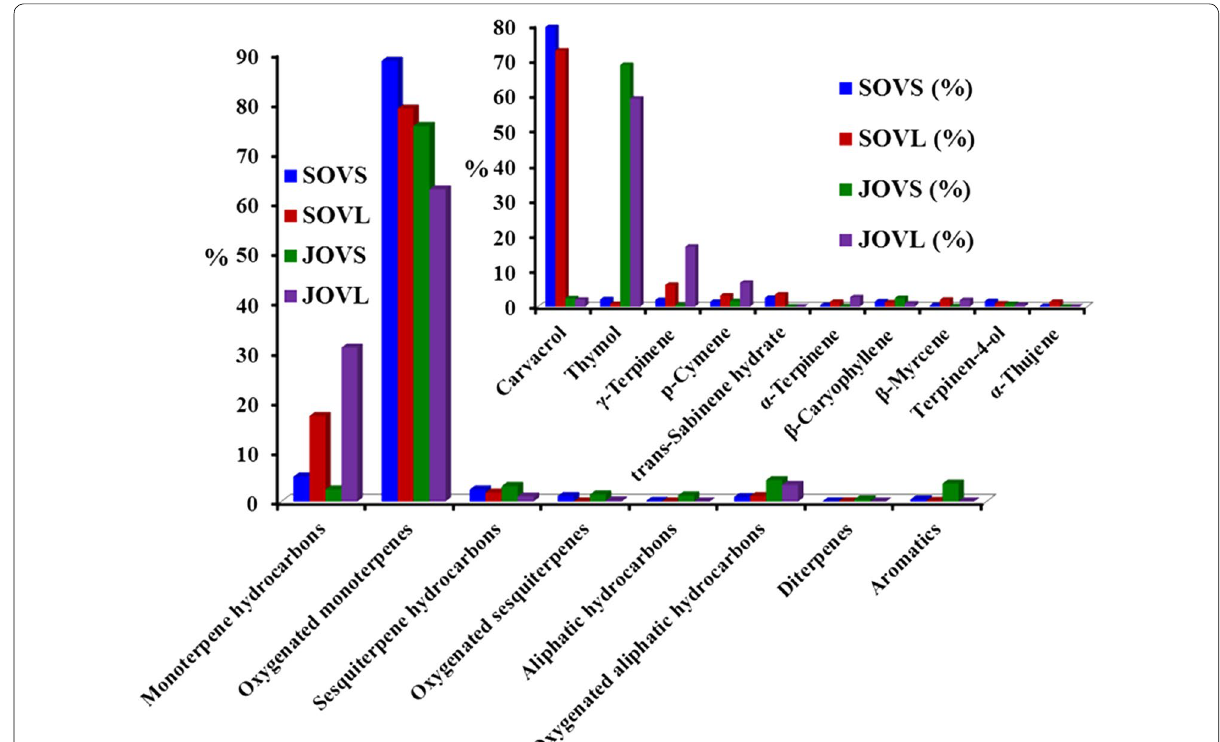
Fig. 3 Content of major compounds and chemical classes in the leaf and stem essential oils of Saudi and Jordanian O. vulgare